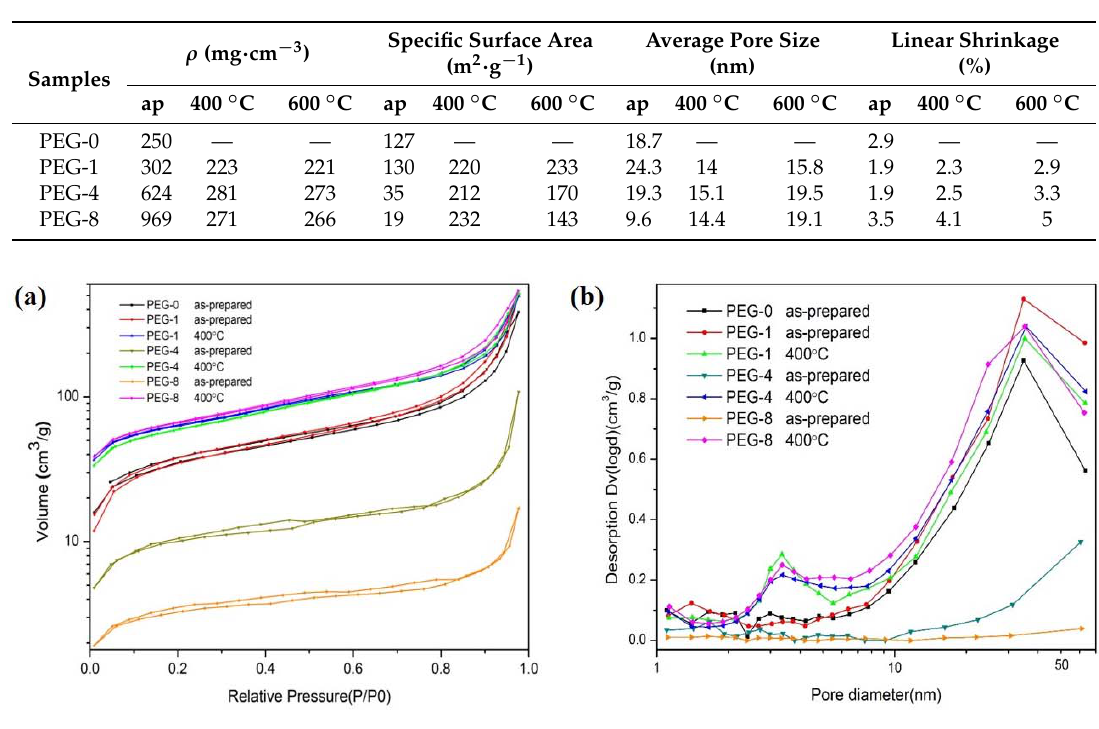
Figure 5. ( a ) Nitrogen absorption/desorption isotherms; ( b ) Pore ‐ size distribution of different silica